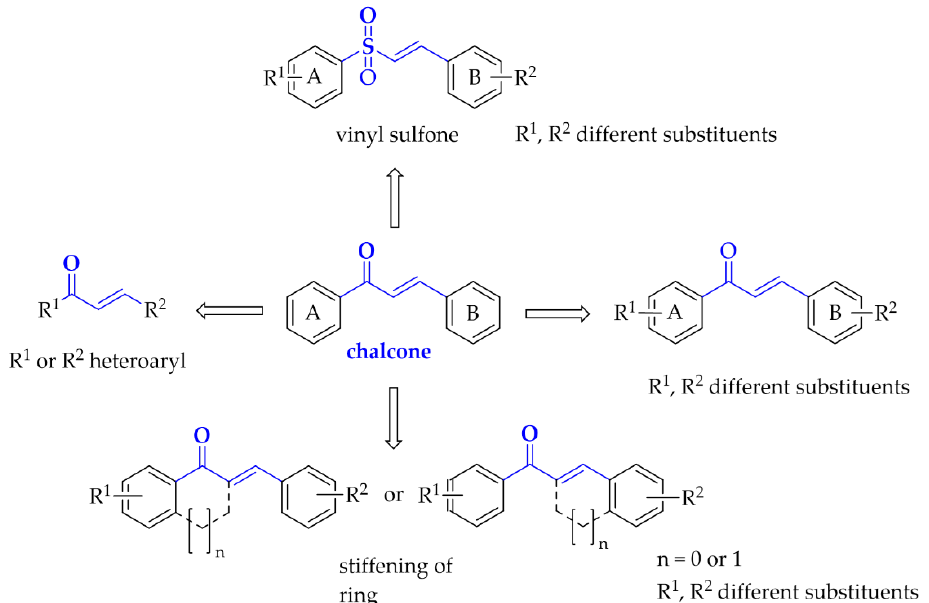
Figure 5. Structural modifications observed in chalcones with potential utility in Parkinson’s disease treatment.